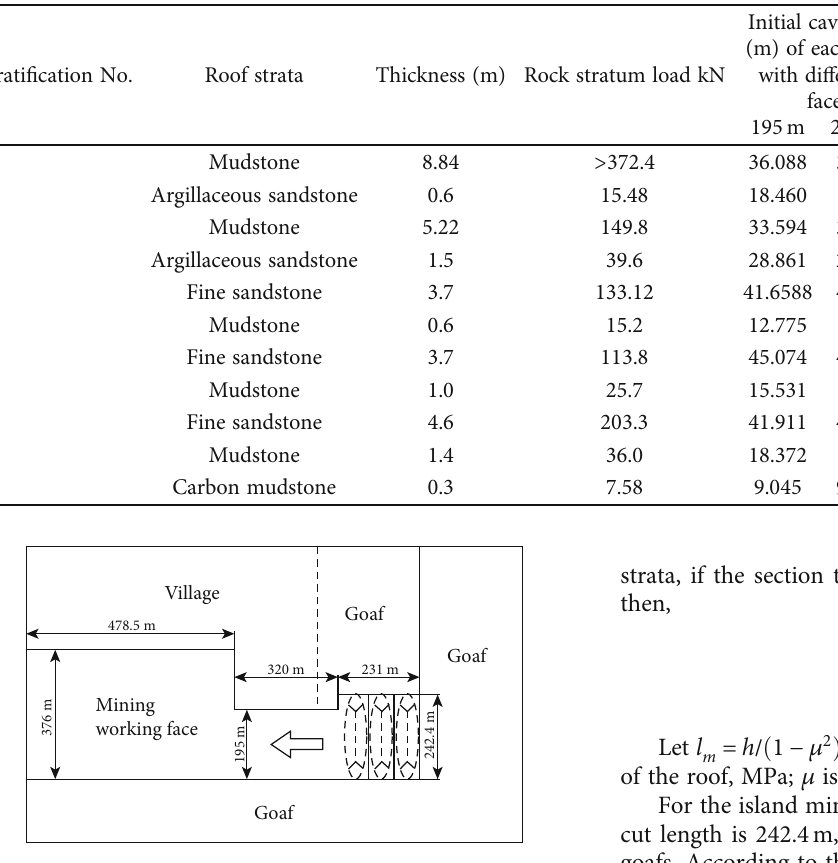
Figure 2: Structure model of 3500 Working